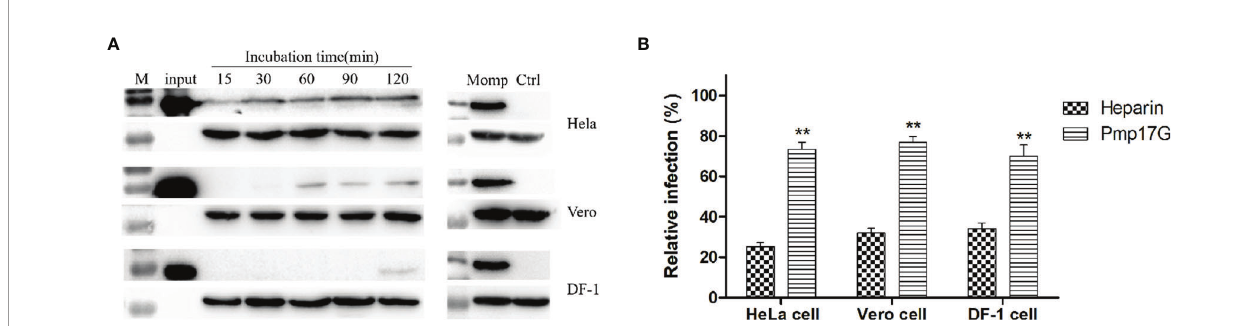
FIGURE 1 | Pmp17G mediated adhesion to host cells, and recombinant Pmp17G blocked C . psittaci infection. (A) HeLa 229 cells, Vero cells and DF-1 cells were incubated with 200 m g/ml Pmp17G, while inactivated EBs at an MOI of 5 were used as a positive control for different durations. Positive bands were reacted with anti- His mAbs or anti-MOMP antibody, and GAPDH was the loading control. (B) HeLa 229 cells, Vero cells and DF-1 cells were pretreated with 200 m g/ml of Pmp17G and 500 m g/ml heparin, as the positive control for 2 h, and then exposed to C . psittaci 6BC at an MOI of 5 for 36-48 h Inclusion-forming units (IFUs) were quanti fi ed by indirect immuno fl uorescence (IIF). Relative Infection (%)=(IFUs of the treated group/IFUs of the PBS group)×100. Statistical analysis was performed by one-way ANOVA, and the data from 3 independent experiments were expressed as the means ± standard deviations (SD). Asterisks indicate statistical signi fi cance: **p <